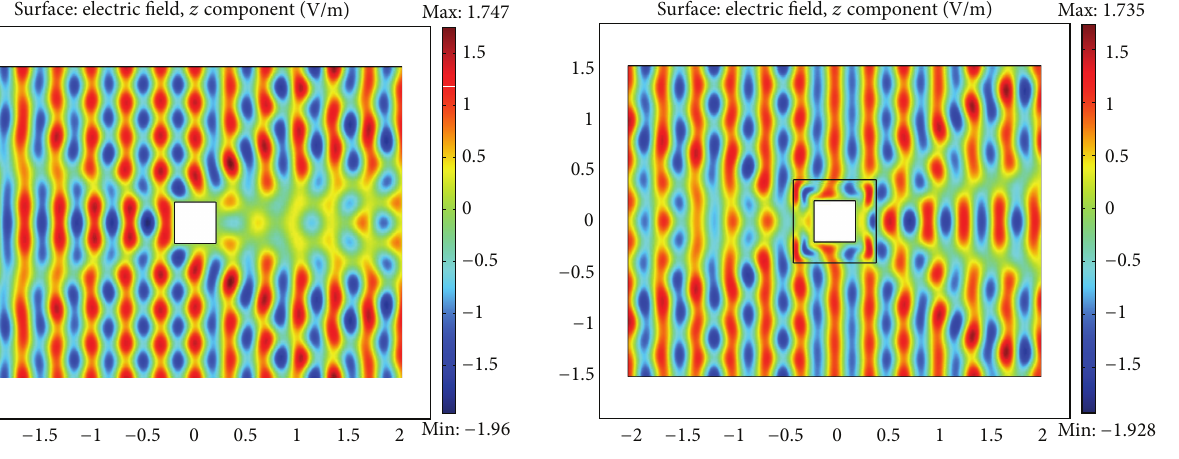
Figure 7: The coverage performance when using the cloak to enhance the signal strength in the shadow